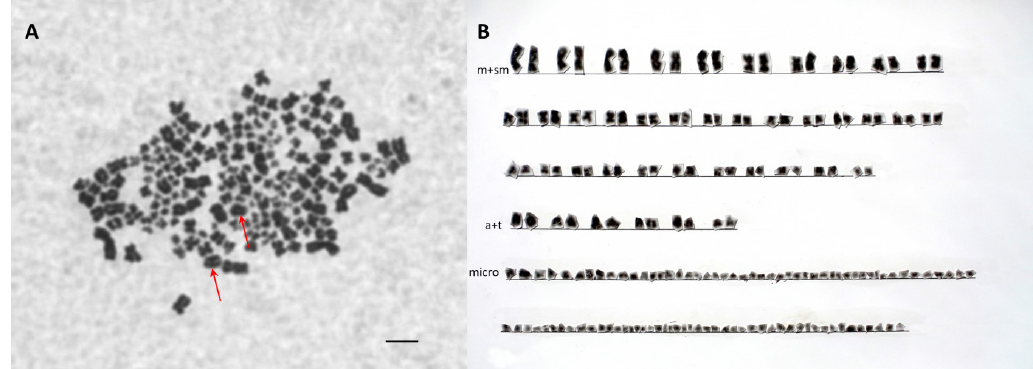
Table 6. Characteristics of karyotypes of triploid and pentaploid hybrids compared with parental species (based on Birnstein et al . ) [3].